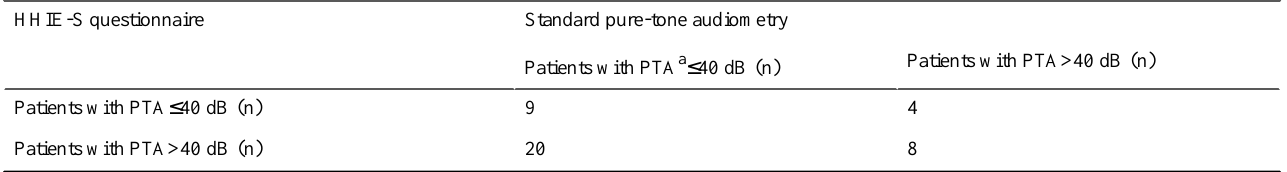
Table 3. Accuracy of the HHIE-S questionnaire as a screening test compared to the standard pure-tone audiometry (N=41).